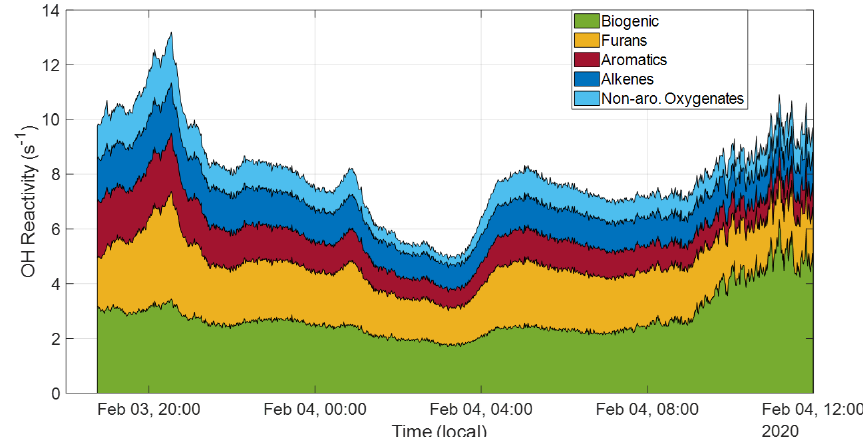
Figure 6. Selected compounds with significantly high smoke-related enhancements are grouped into categories of varying reactivity based on known reactivity groups, except for the “isoprene + monoterpenes” group, which is the sum of isoprene ( m/z 69) and monoterpene ( m/z 137) reactivities. This captures every compound included in this OH reactivity